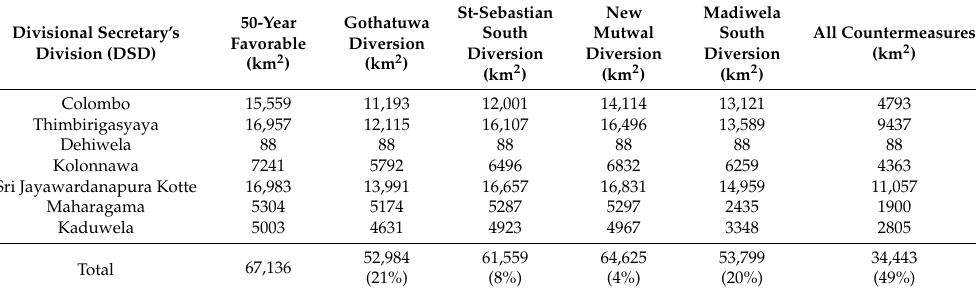
Table 8. Impact residents in DSDs comparison for different